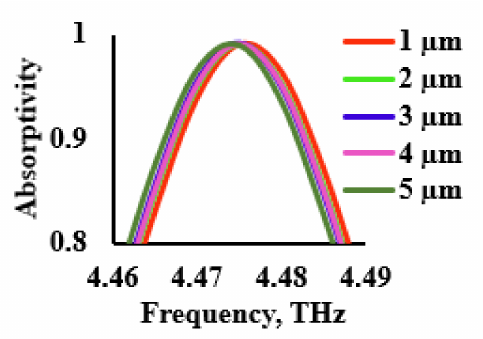
Figure 14. Performance of the sensor for various analyte thicknesses.